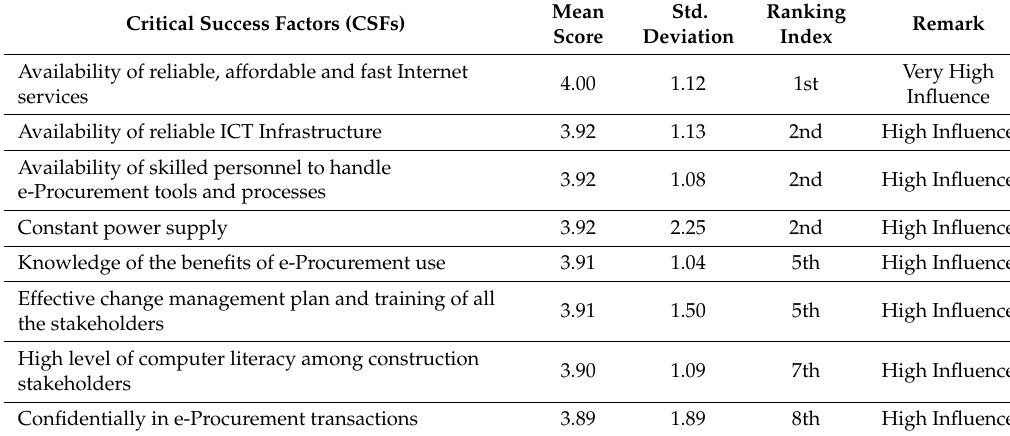
Table 6. Critical success factors for the adoption of e-Procurement